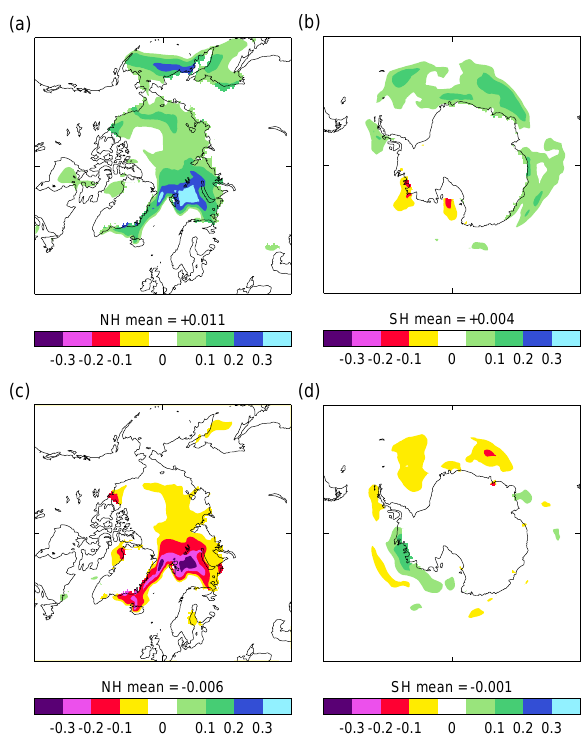
Fig. 5. Difference in HadGEM2 decadal-mean hemispheric sea-ice fractions between: (a & b) the A1B-plus-geoengineering and A1B simulations meaned over the second decade of simulation, and (c & d) the second decade of A1B and the 1990-1999 period in the historical simulation.